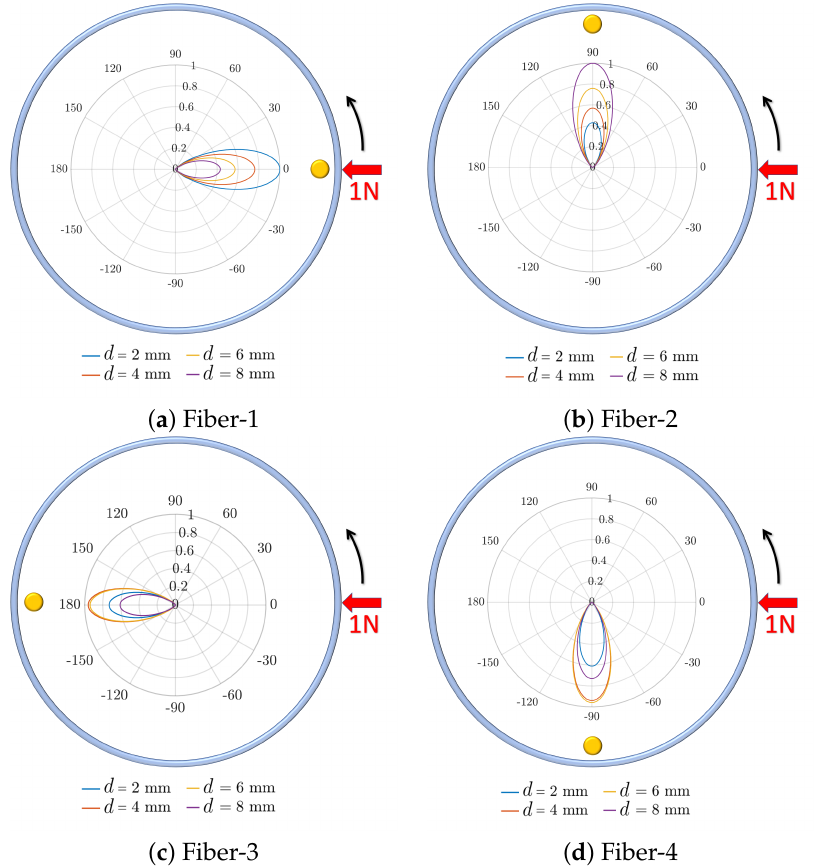
Figure 7. Normalized variation of the maximum deflection in ( a ) optical Fiber-1, ( b ) Fiber-2, ( c ) Fiber- 3 and ( d ) Fiber-4 with respect to the change in the longitudinal and circumferential positions of external